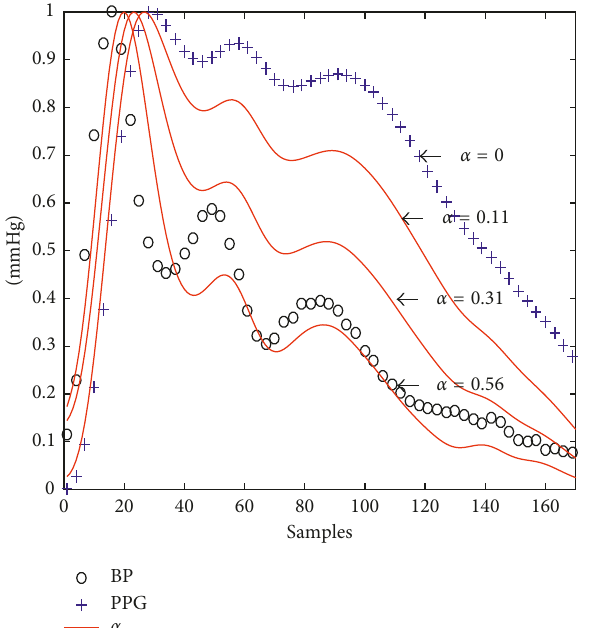
Figure 6: Fitting from PPG to BP by fractional derivatives, the parameter α controls the degree of the